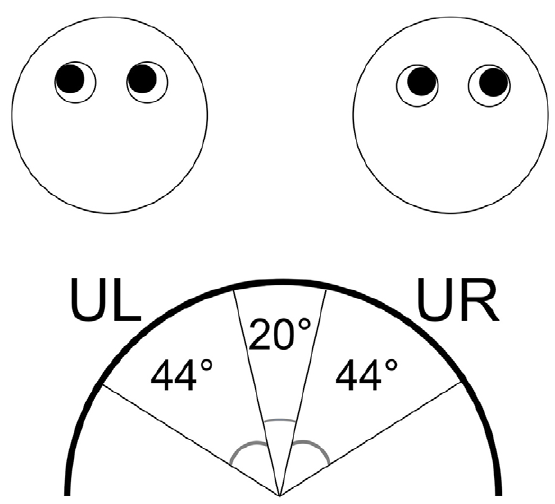
Figure 2. The areas of eye-movements classified as Upper Left and Upper Right (seen from the coder’s point of view).